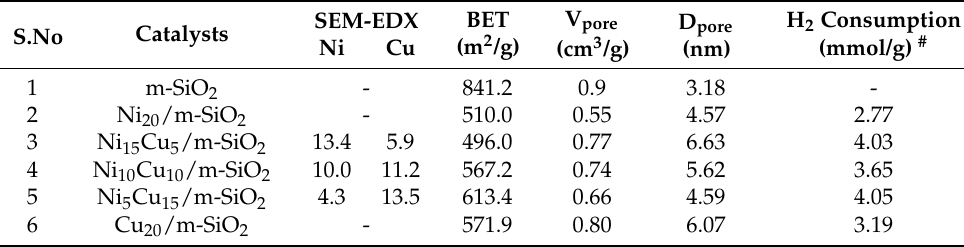
Table 2. Physicochemical properties of various amounts of Ni-Cu on SiO 2